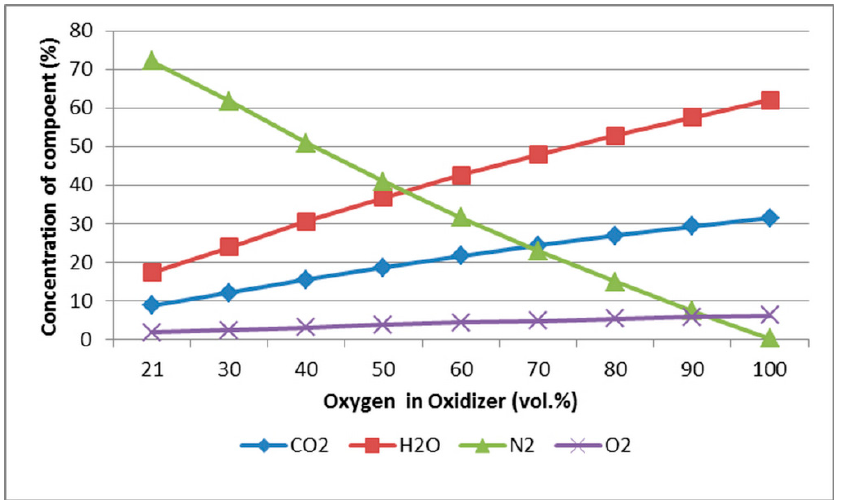
Figure 4. Graphs of dependence of concentration of components (natural gas, flue gas) as a function of oxygen concentration in the oxidizer ( m = 1.1) (mathematical modeling).